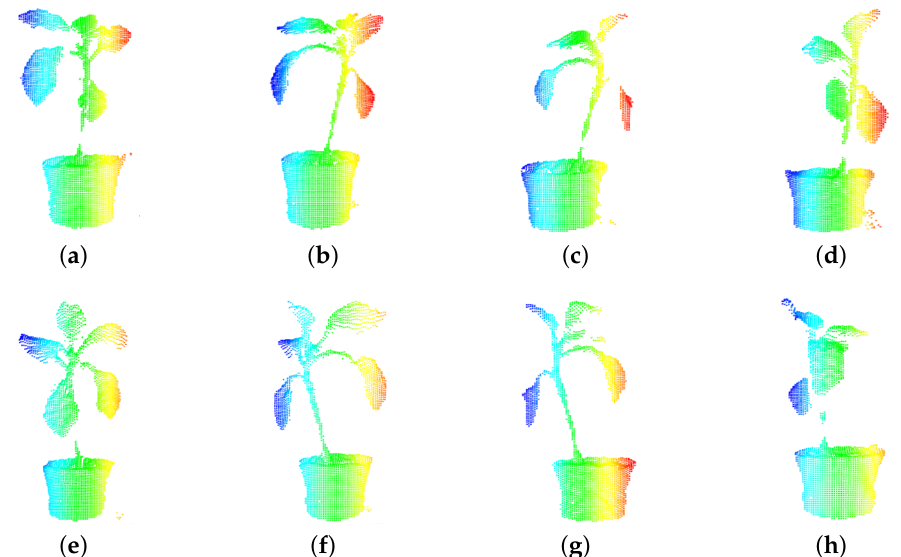
Figure 3. Color render plant’s point clouds of angle 0 − 7 according to x -axis direction. ( a ) point cloud of angle 0 ; ( b ) point cloud of angle 1 ; ( c ) point cloud of angle 2 ; ( d ) point cloud of angle 3 ; ( e ) point cloud of angle 4 ; ( f ) point cloud of angle 5 ; ( g ) point cloud of angle 6 ; ( h ) point cloud of angle 7